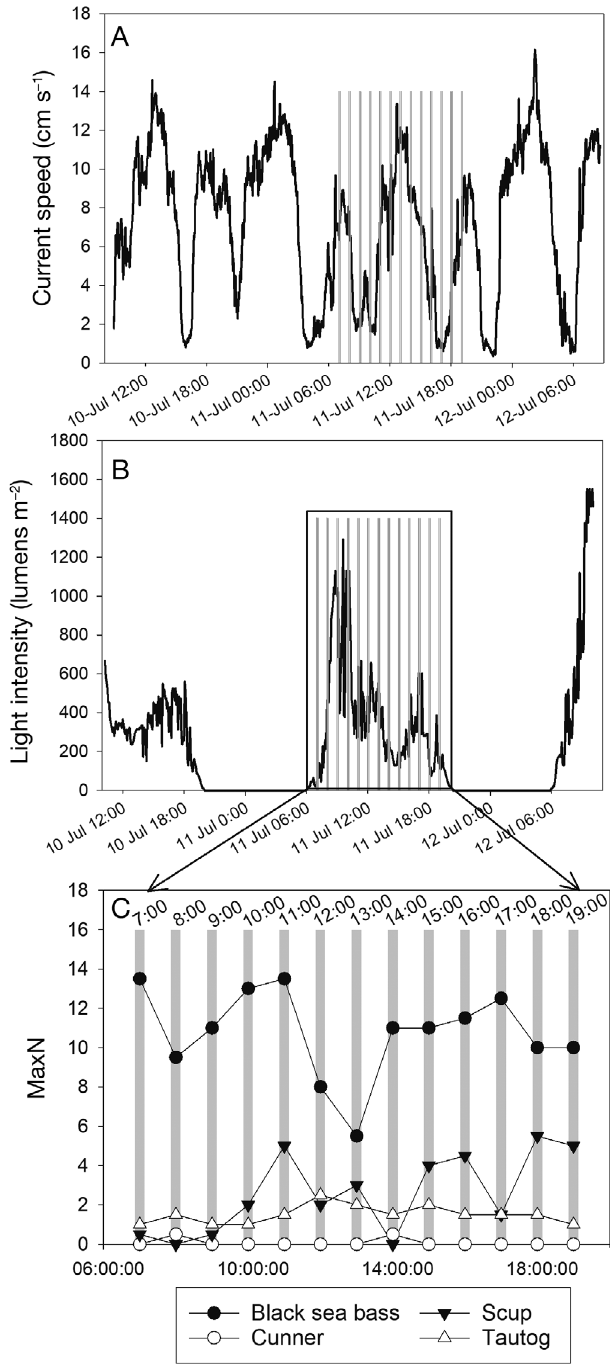
Fig. 4. Collection of environmental parameters in conjunc- tion with video observations in July 2017. Gray bars in all panels indicate timing of video collection. (A) Black lines in- dicate current speed (cm s −1 ) measured every minute, plot- ted as a 5-point running smooth. (B) Black lines indicate light intensity (lumens m −2 ) measured every 5 min. (C) Fish abundance of the 4 most commonly observed species from our full dataset; each point represents the observed MaxN during an 8 min video